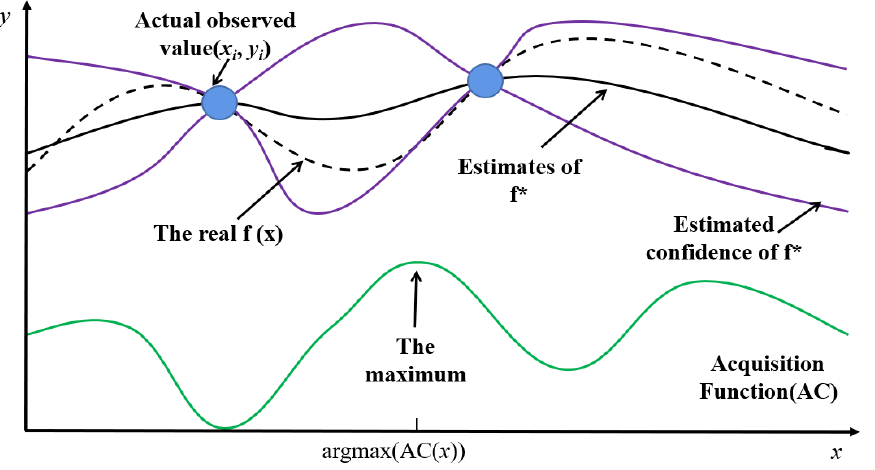
Figure 7. The hyperparameter tuning process of Bayesian optimization.